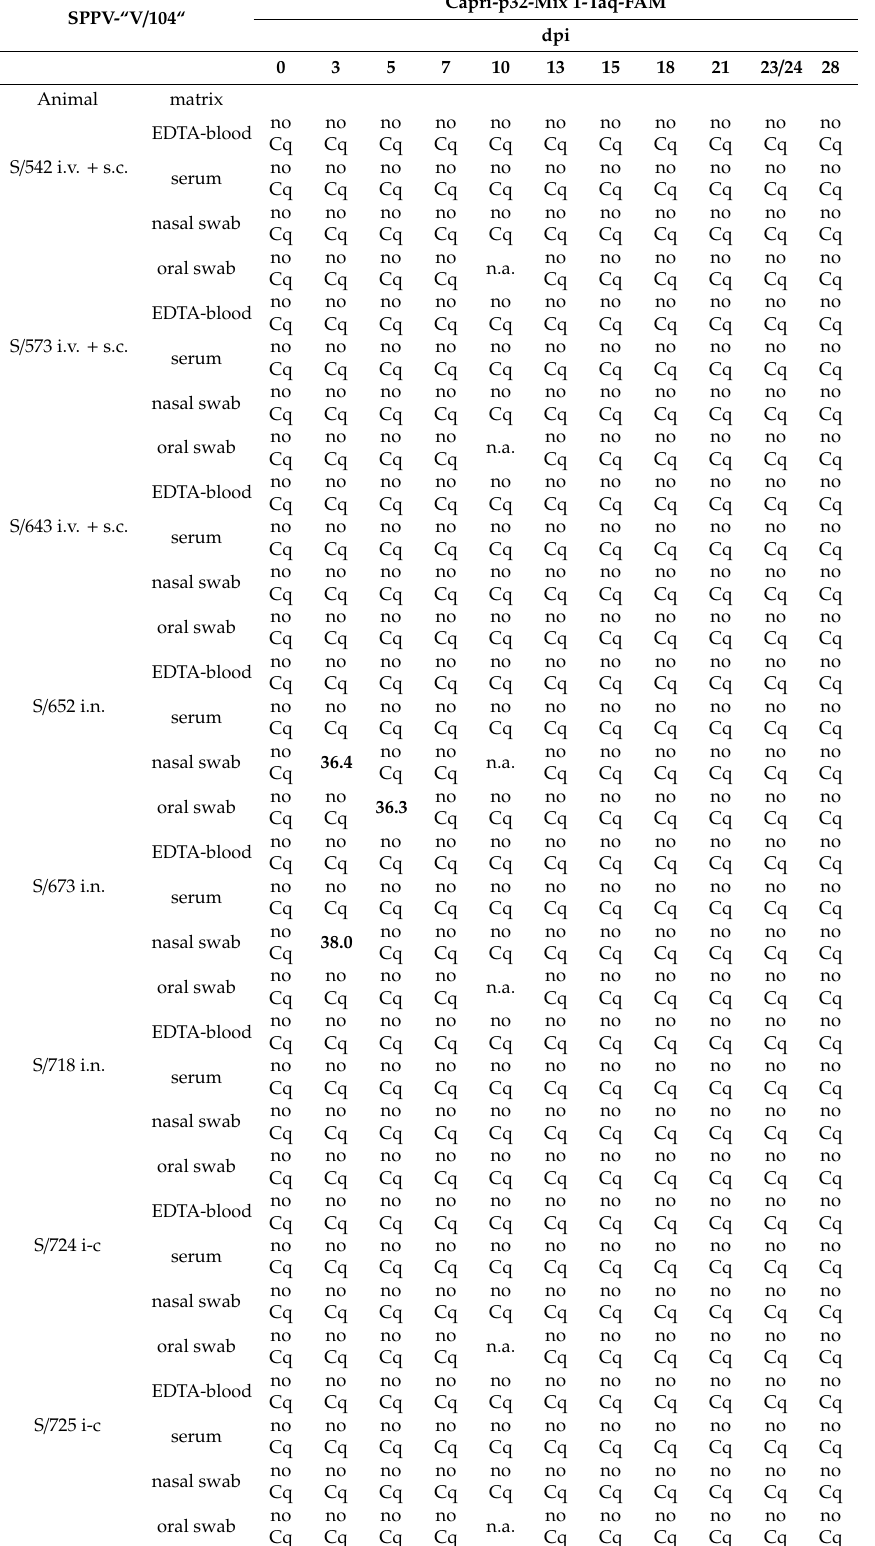
Table 1. Results (Cq values) of EDTA-blood, serum, nasal, and oral swabs taken from sheep inoculated with SPPV-“V / 104“ analyzed via the pan Capripox real-time qPCR. SPPV-“V / 104“